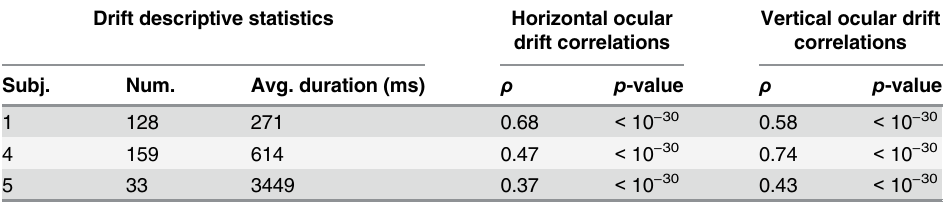
The three columns on the left side of the table indicate the subject and descriptive statistics for the given subject. The four columns on the right are the Spearman correlation coef fi cients ( ρ ) and the p -values obtained for each correlation in the horizontal and vertical